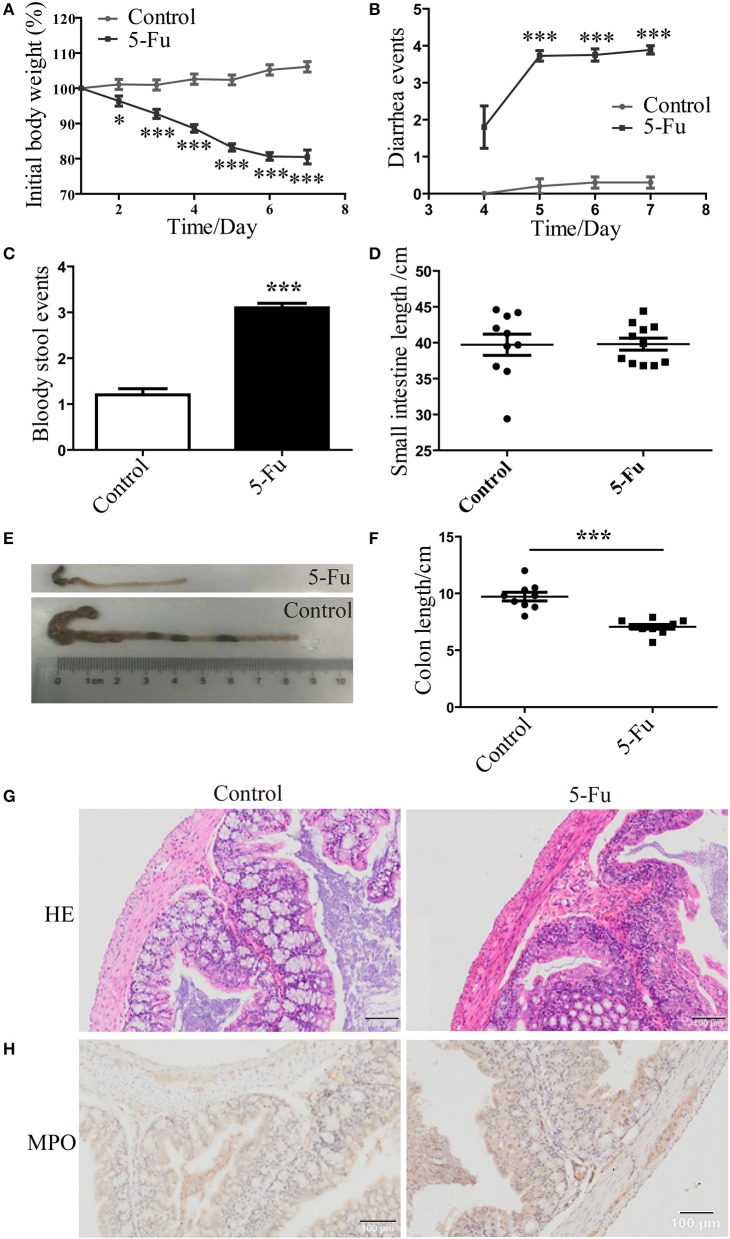
5-Fu induced mucositis and colon shortening in mice. (A) 5-Fu induced body weight changes. Data were plotted as percentage of initial body weight. (B) The occurrence of diarrhea. Data represented the evaluation scores of diarrhea. (C) The bloody stool events measured by BASO testing paper. (D) The small intestine length. (E,F) The colon length. (G) HE staining of colonic sections. (H) MPO staining of colonic sections. Values were expressed as mean ± S.E.M (n = 10/group). Data were analyzed by t-test. *P < 0.05, ***P < 0.001 vs. control group.